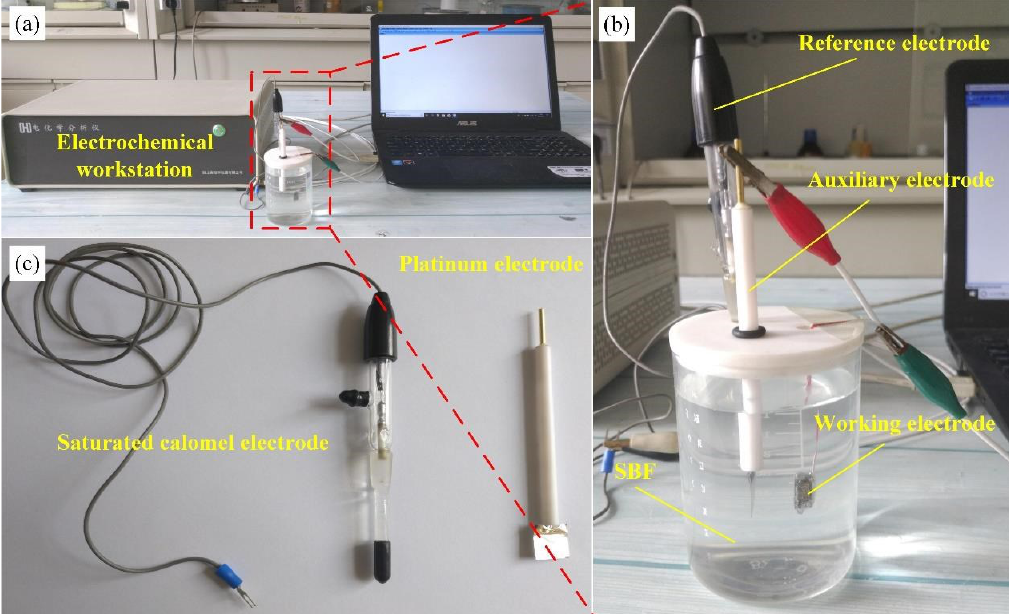
Figure 2. Physical connection diagram of electrochemical workstation: ( a ) general connection drawing of electrochemical workstation; ( b ) enlarged view of connection; ( c ) schematic diagram of the